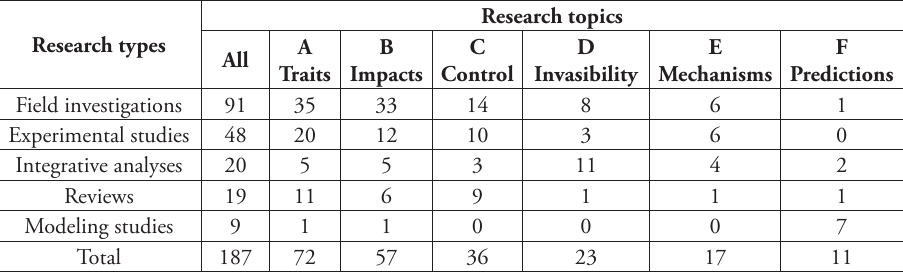
table 1. Classifications of 187 papers on plant invasions in China, published in the period 2001–2010 and referenced in the ISI Web of Knowledge, according to research types and research topics: A – biologi- cal features of non-native plants; B – impacts of plant invasions; C – control approaches; D – invasibility or environmental factors related to plant invasions; E – mechanisms of plant invasions; F – predictions of the distribution of non-native plants. Some papers have been attributed to more than one